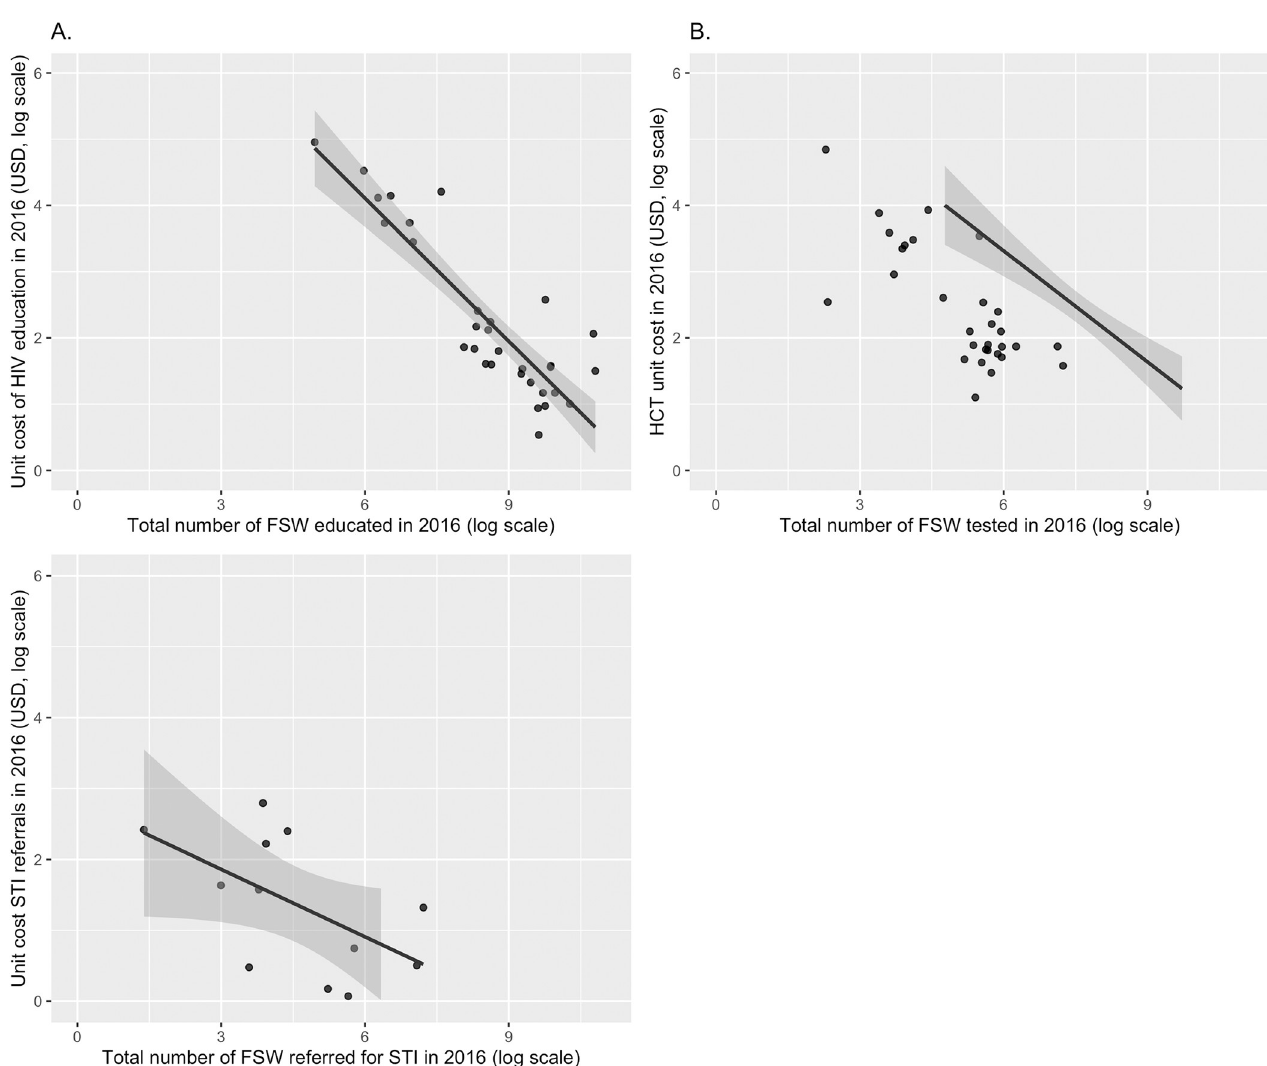
Fig 5. Unit cost and scale of services among a sample of Nigerian CBOs providing (A) HIV education services and (B) HIV counselling and testing services, and (C) STI referrals.